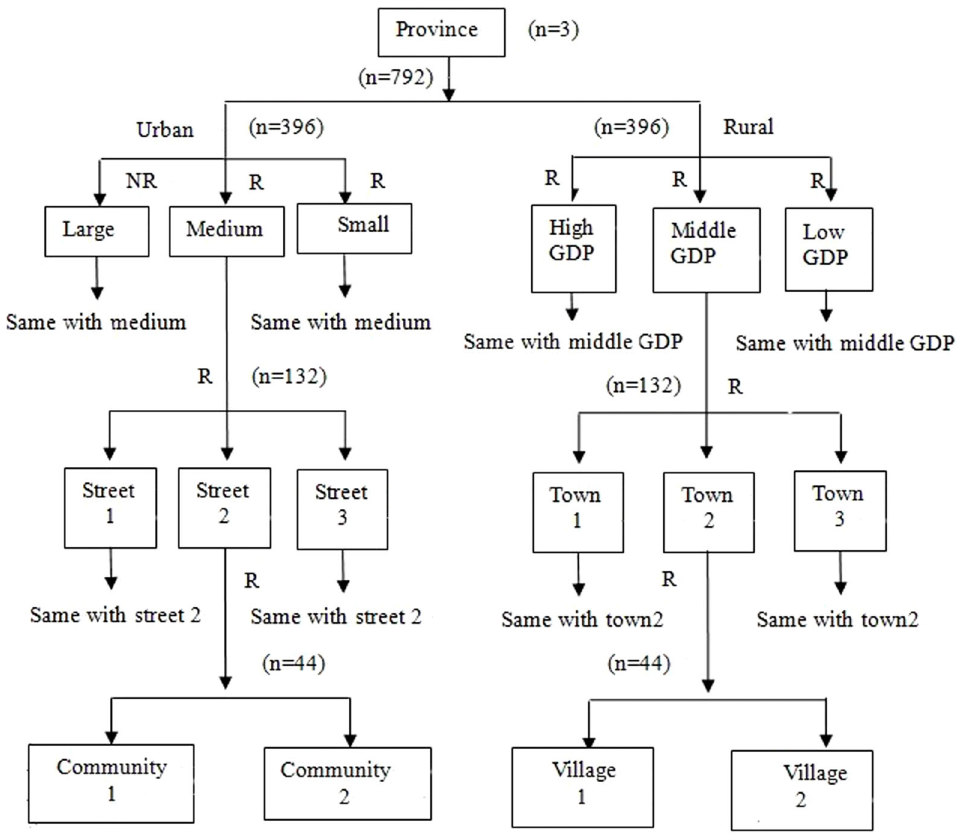
Figure 1. The flow chart shows a multistage stratified random sampling technique of the present study used per the overall design of the third China National Oral Health Survey. The number of subjects participated in the study in each category has been indicated. NR, non- randomized sample; R, randomized sample.